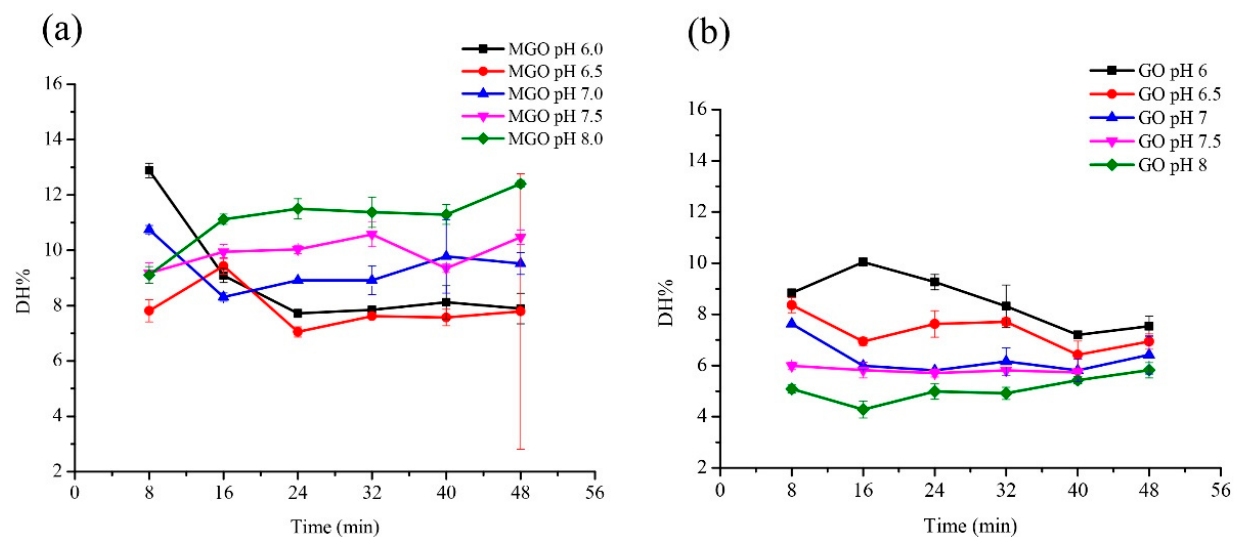
Figure 3. Effect of pH and duration on the digestibility of glycated glutenin derived from MGO and GO. ( a ) Glutenin (1 mg/mL) with MGO (40% aqueous solution) was incubated in different pH solutions (6.0, 6.5, 7.0, 7.5, 8.0) at 100 °C for 8, 16, 24, 32, 40, and 48 min with the mass ratio of glutenin to GO of 1:5. ( b ) Glutenin (1 mg/mL) with GO was incubated in different pH solutions (6.0, 6.5, 7.0, 7.5, 8.0) at 100 °C for 8, 16, 24, 32, 40, and 48 min with the mass ratio of glutenin to GO of 1:5. Data show the means ± SD of triplicate independent experiments. Bars represent the standard error of the mean.